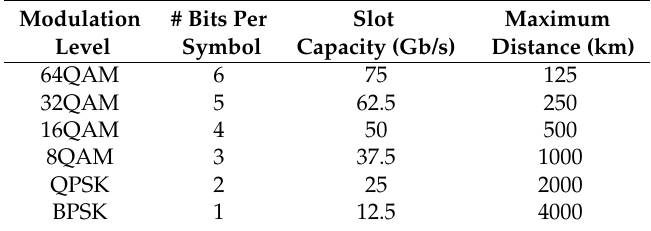
Table 2. Modulation Characteristics.